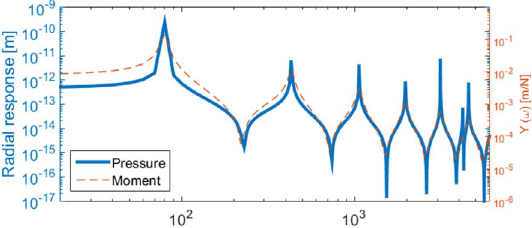
Figure 19. De fl ection at the end of the asymmetric tube excited by pressure and bending moment.